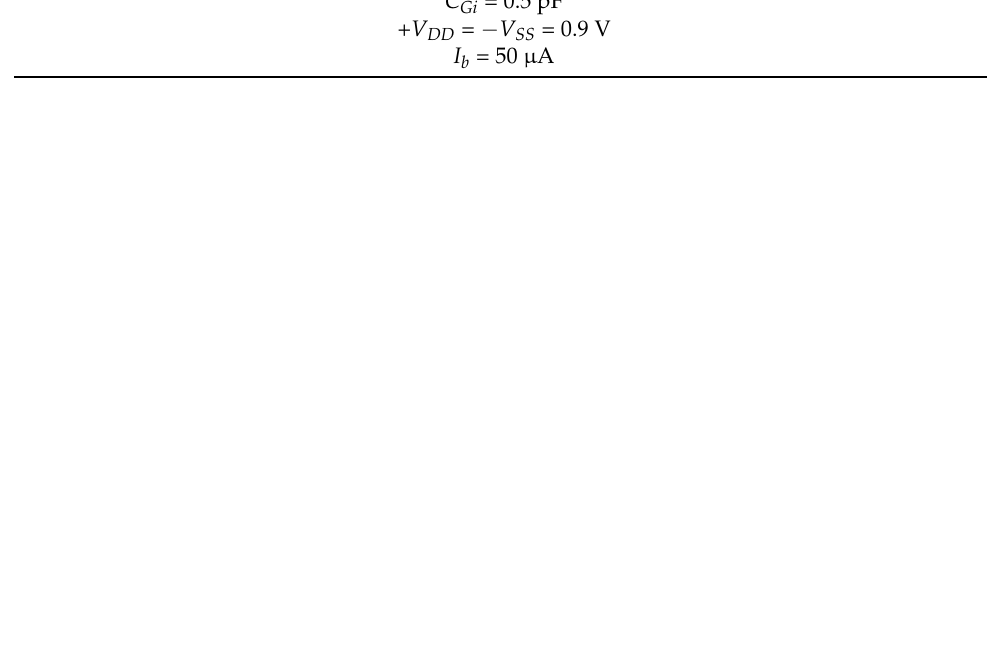
Table 1. Transistor aspect ratios and component values.